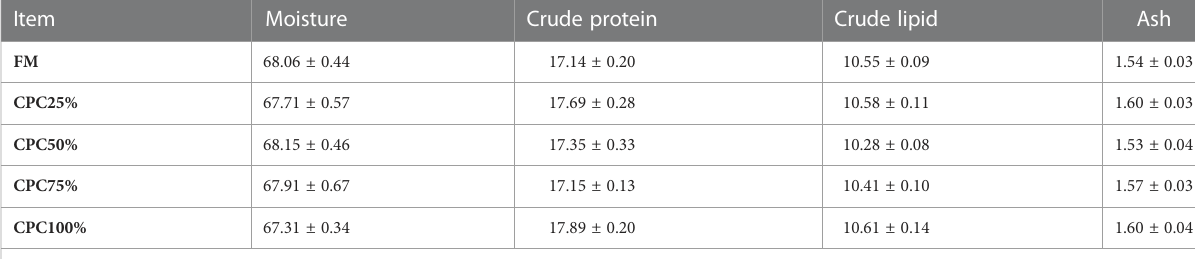
TABLE 5 Chemical composition of whole-body fi sh fed diets containing graded CPC (mean ± S.E, n =8).